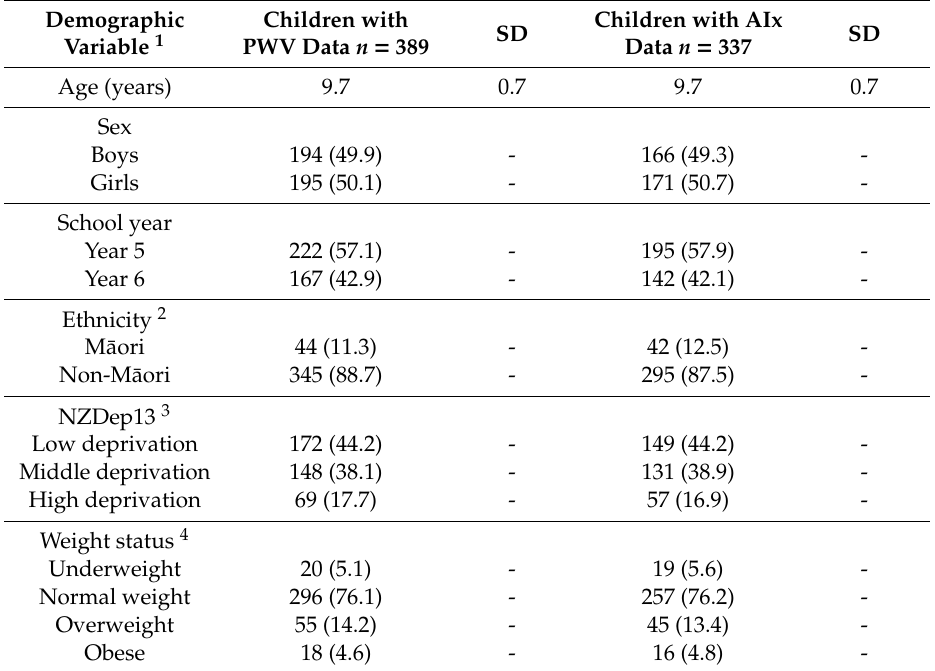
Table 1. General characteristics of the PEDALS population with PWV or AIx